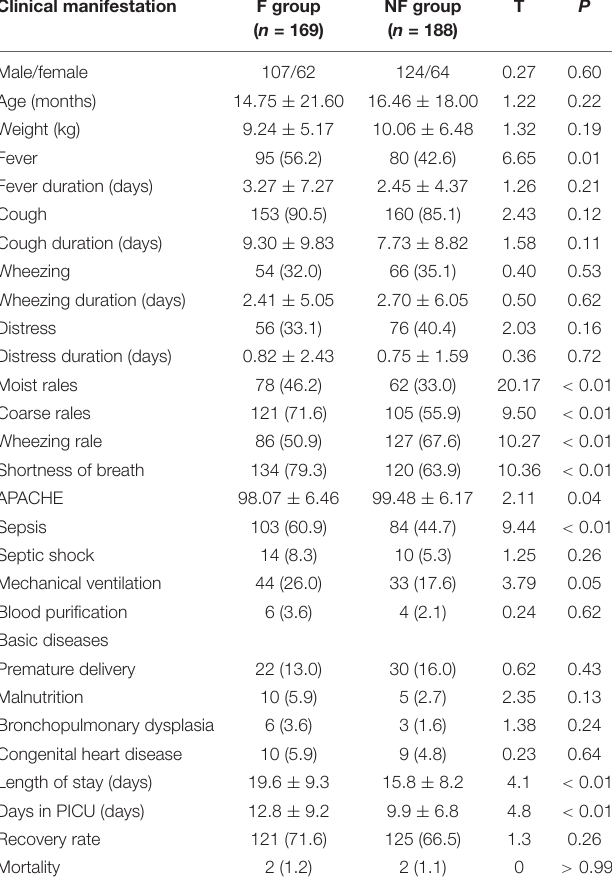
TABLE 3 | Comparison of the serum and BALF GM levels between groups.